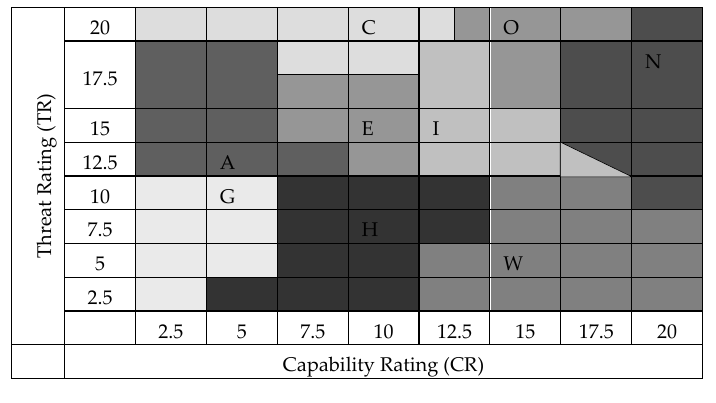
Figure 2. Attackers’ classes [40].